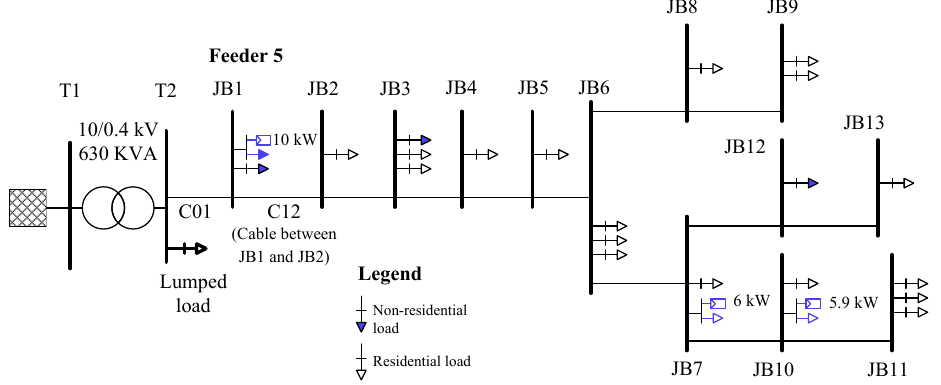
Figure 4. Representative LV grid used in simulation